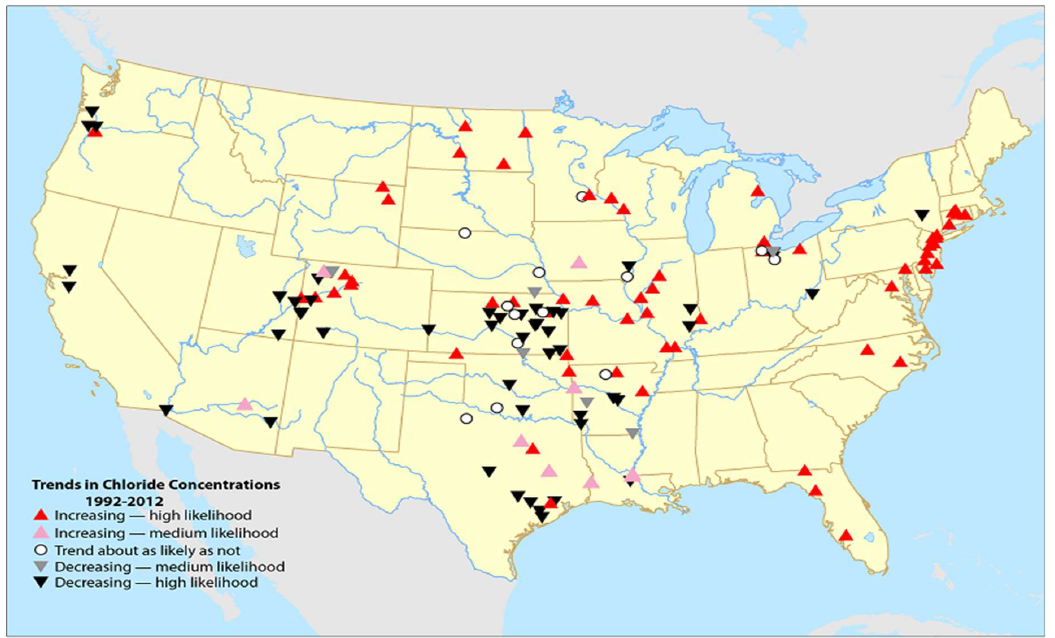
Figure 1. Chloride concentration trends from 1992 to 2012 in the USA show regional differences (modified from United States Geological Survey Report, 2014)